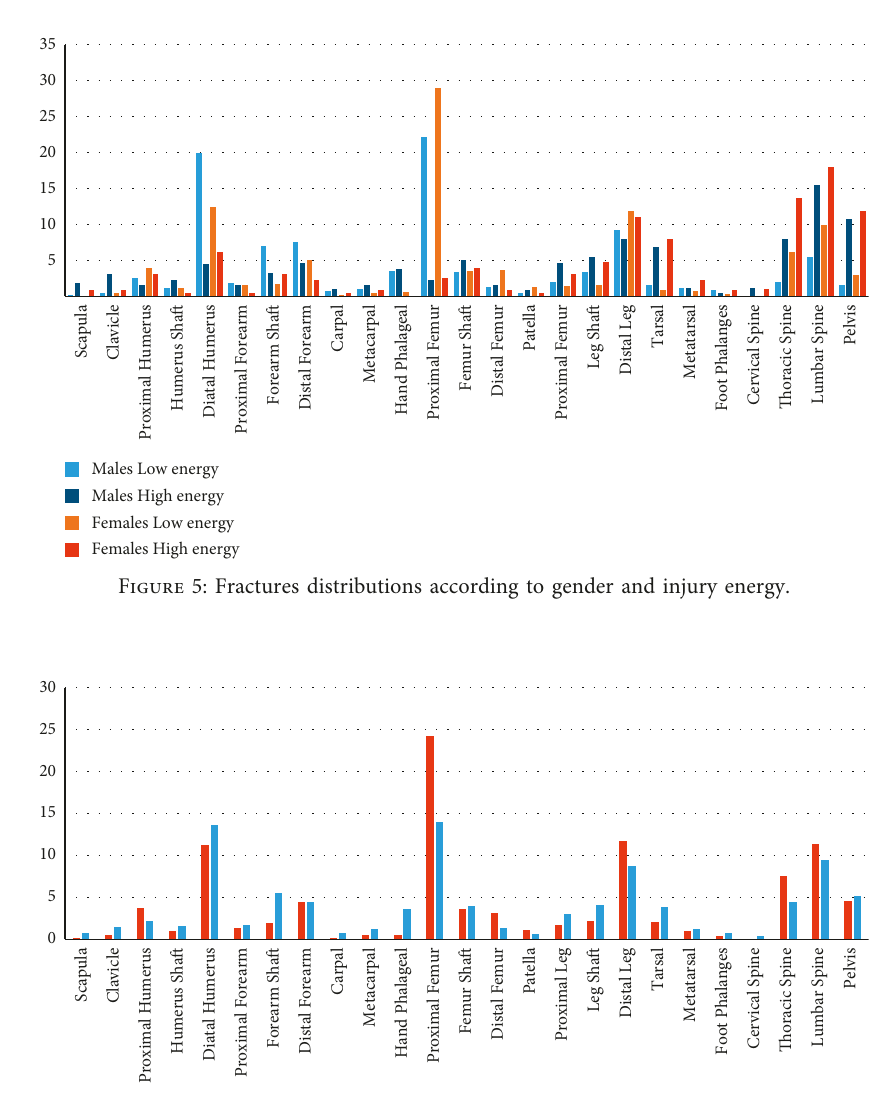
Figure 4: Fracture frequency according to injury energy according to the anatomical region of the body.